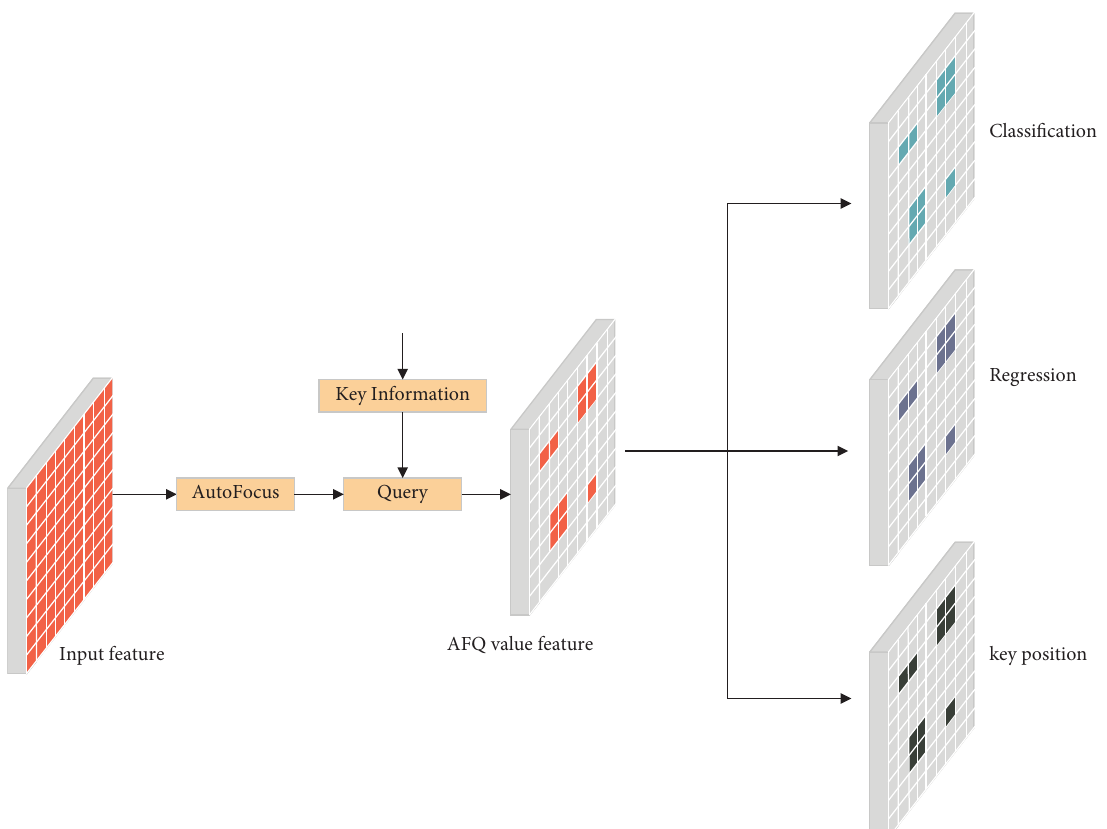
Figure 6: Schematic diagram of the AFQ